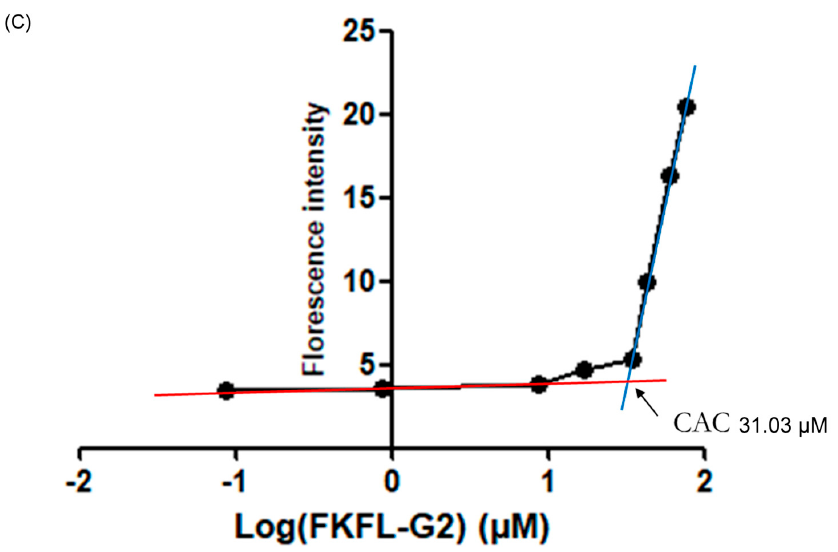
Figure 2. ( A ) Proton nuclear magnetic resonance data of FKFL-G2. ( B ) Matrix-assisted laser desorption/ionization–time-of-flight mass spectrometry data of FKFL-G2. ( C ) Critical aggregation concentration of FKFL-G2. Table 1. Zeta potential and mean diameter values of FKFL-G2.